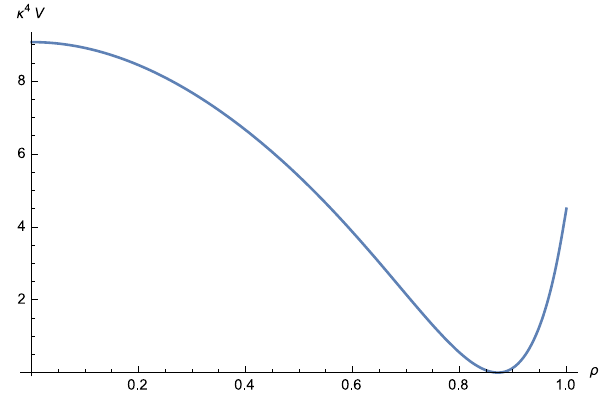
Fig. 2 A plot of the scalar potential with A = 1 / 2, q = 1, and f given by Eq. (38). Notice that the potential indeed has a Minkowski minimum at ρ = 0 .